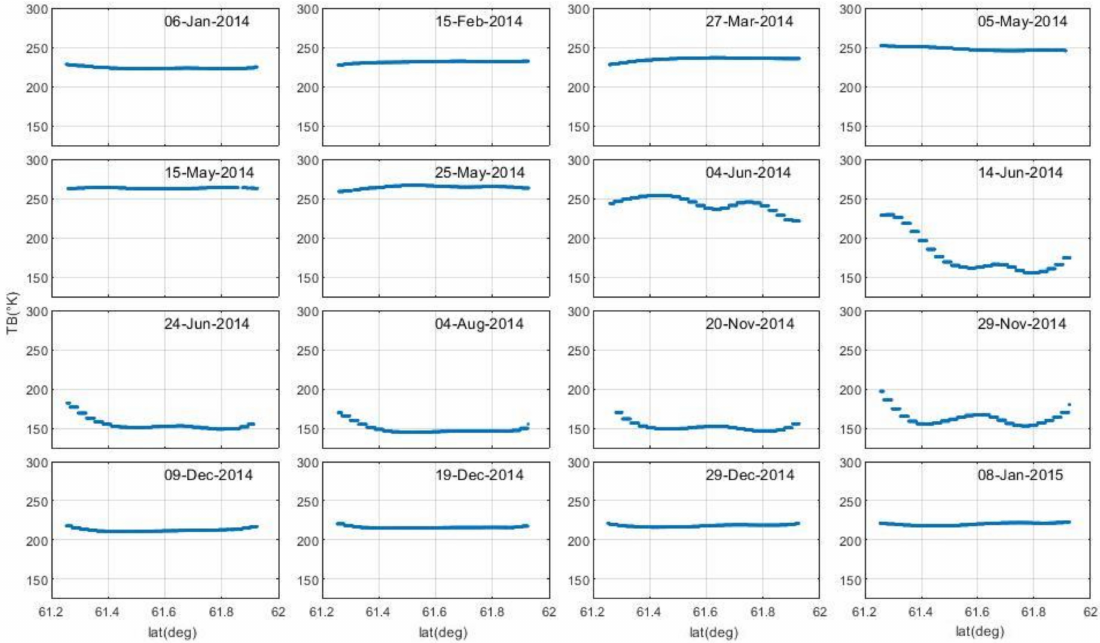
Figure 5. Profiles of average brightness temperature along Jason-2 track 045 over Great Slave Lake from January to December